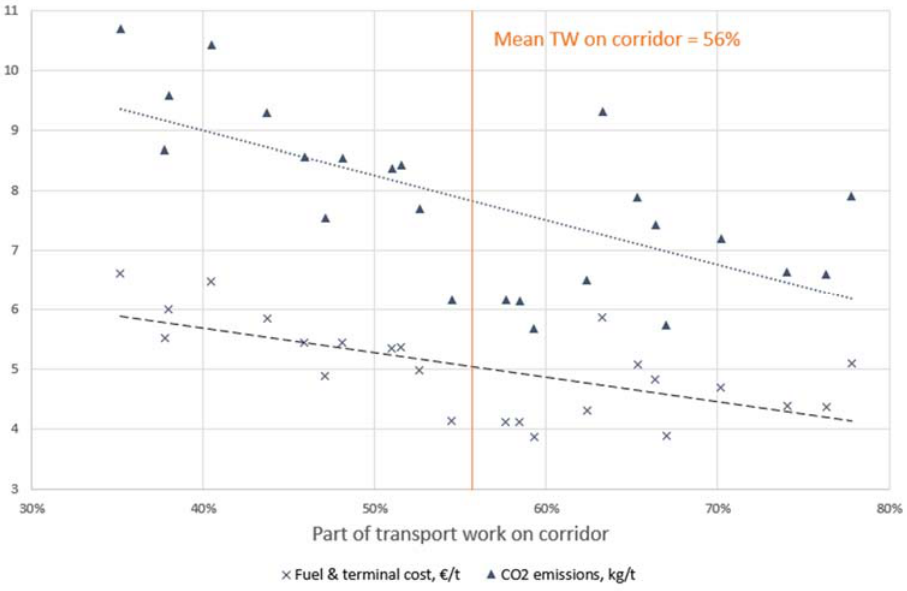
Figure 8. Identified corridor system’s cost and emissions (y axis) compared to how much of the corridor system’s transport work was accommodated by the HCT corridor itself (x axis).